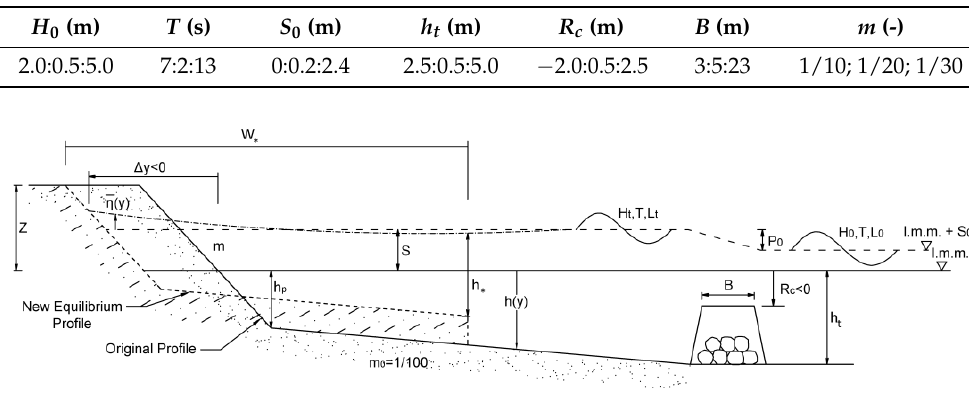
Figure 3. Sketch of the main parameters used in the integration.